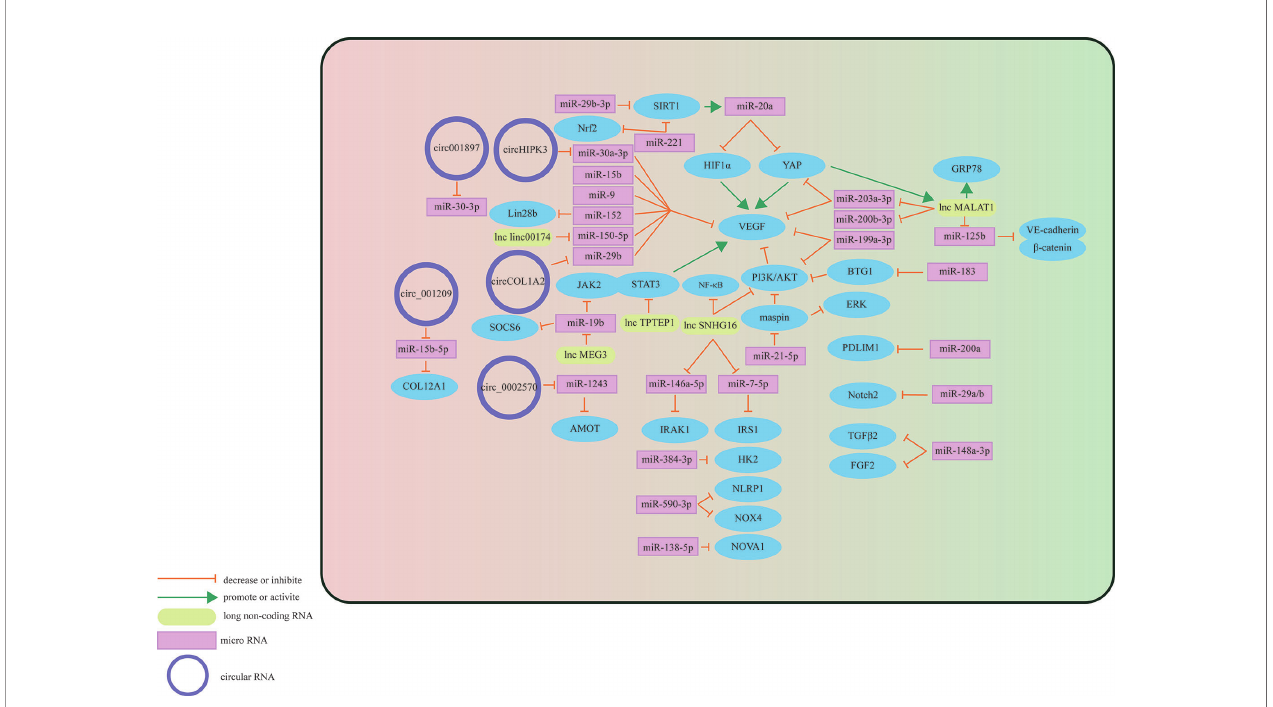
FIGURE 2 | Schematic overview of miRNAs, lncRNAs, and circRNAs affecting vascular endothelial cells and contributing to the pathogenesis of